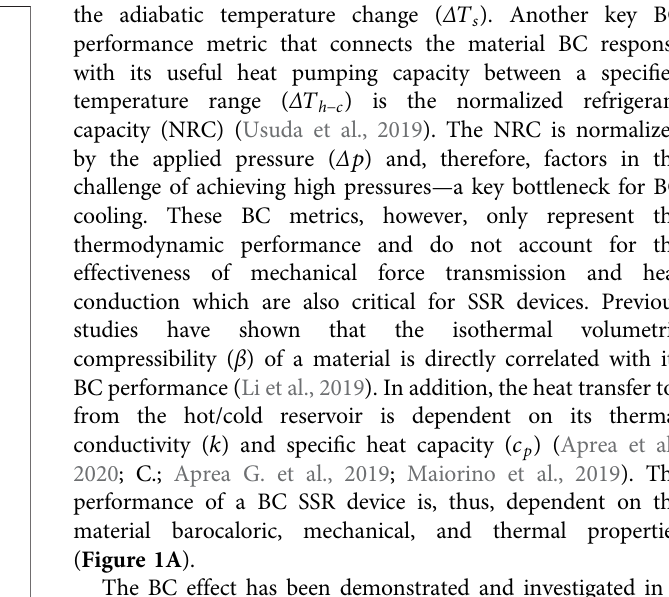
Frontiers in Energy Research |